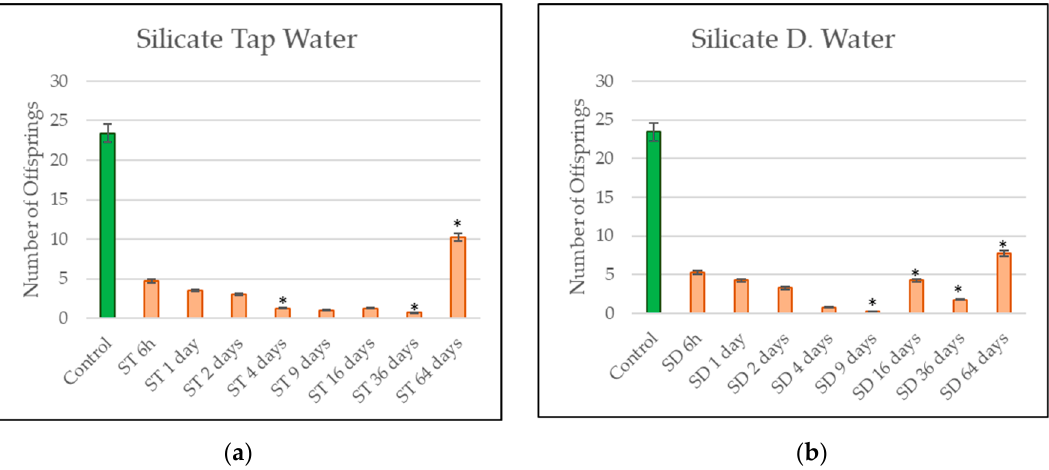
Figure 5. ( a ) Enchytraeid reproduction results for the silicate leach using tap water. ( b ) Enchytraeid reproduction results for the silicate leach using distilled water. Significant results are marked with an (*).